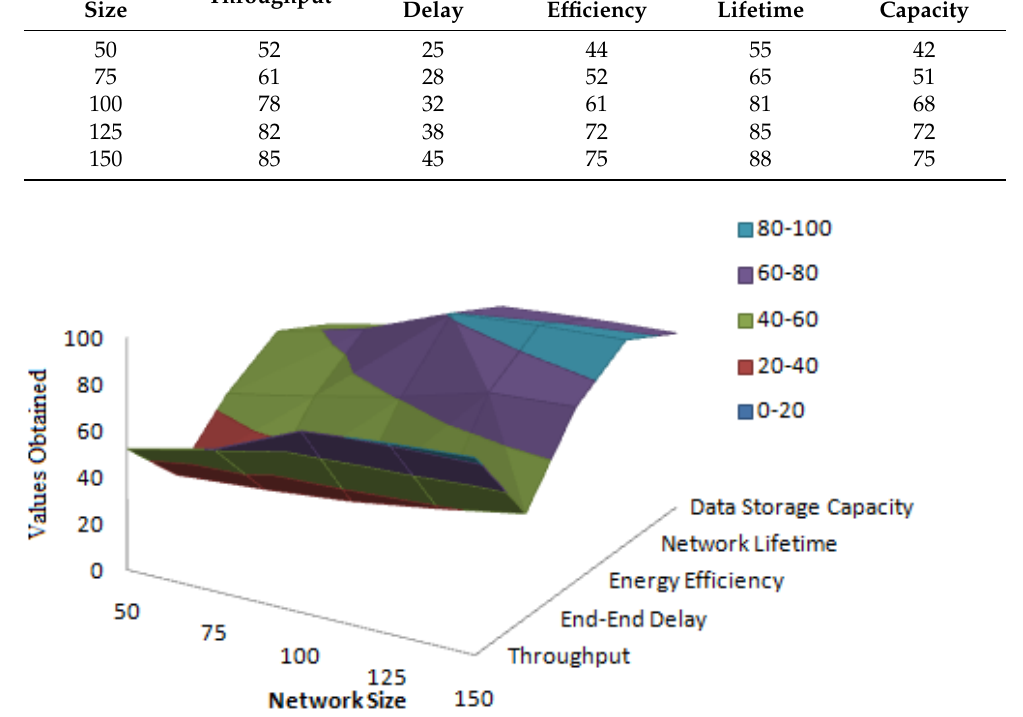
Figure 13. Overall comparison of MLRP-HTEEN-UDSP.